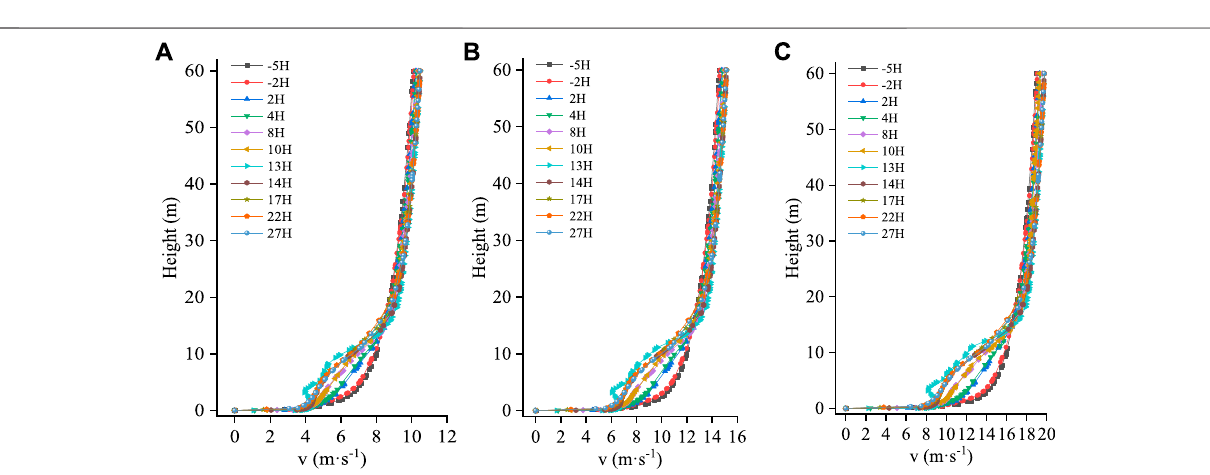
Frontiers in Environmental Science |